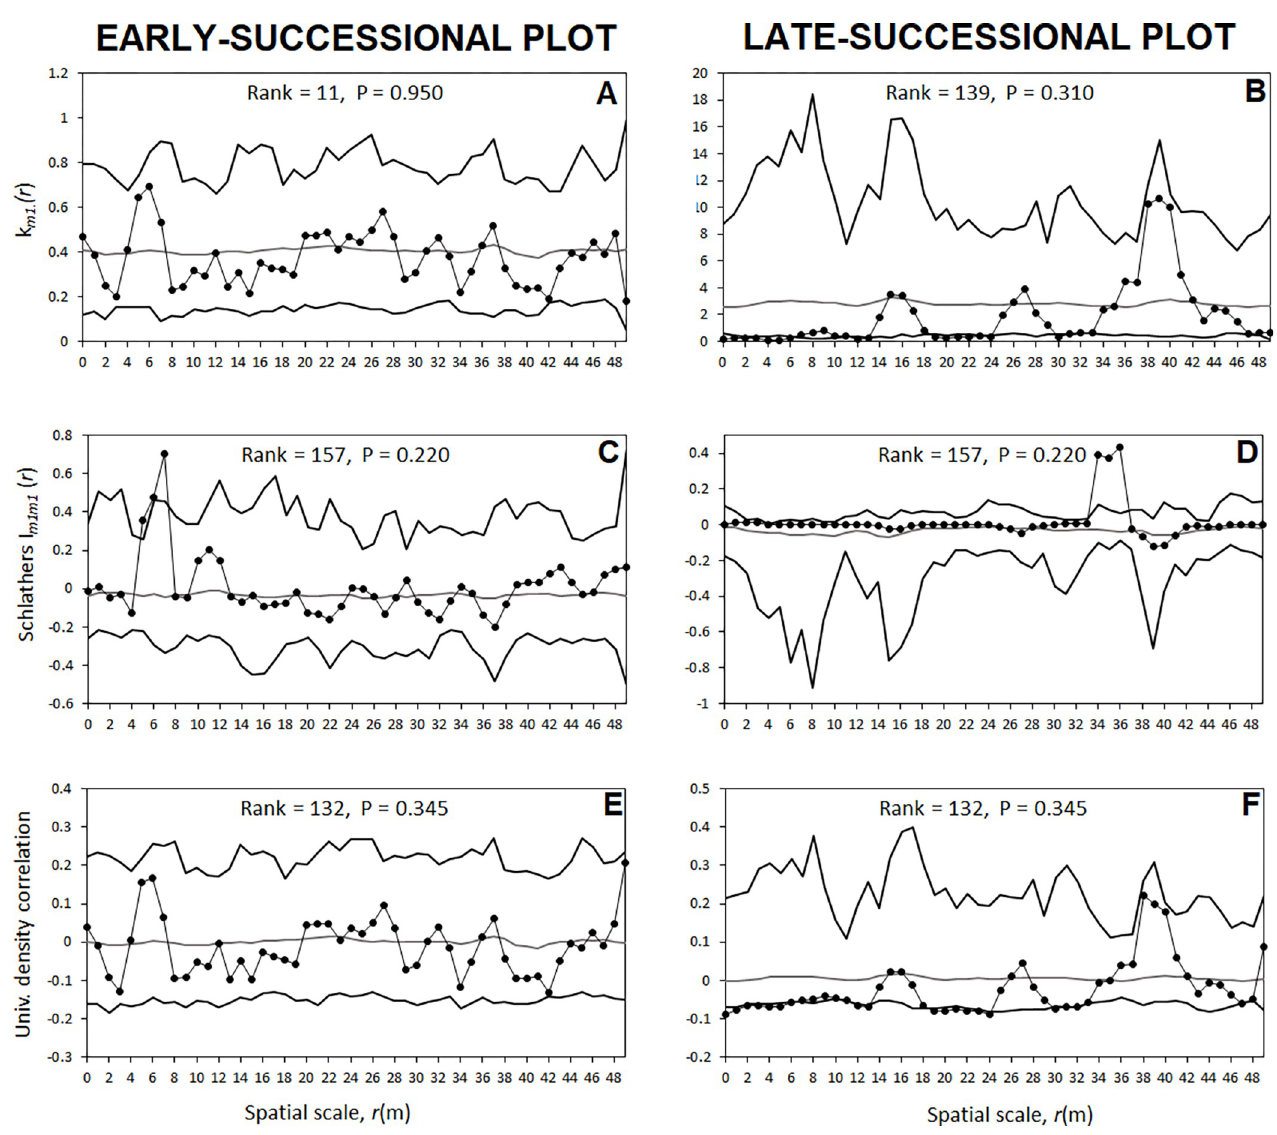
Fig 7. Mark correlation functions to evaluate a potential spatial structure in the number of dispersed seeds found on C . humilis in the early and late- successional study plots. (A, B) The r-mark correlation function describes the mean number of seeds (m i ) on a C . humilis at distance r of another C . humilis . (C, D) Schlather’s correlation function quantifies the correlation between the number of seeds on two different C . humilis separated by distance r. (E, F) Density correlation function assesses the correlation between the number of seeds and the number of neighbours located at a distance r. The expected mark connection function statistics (gray line) and the corresponding simulation envelopes (black lines), being the fifth lowest and highest values of the functions created by 199 simulations under random labelling, are also